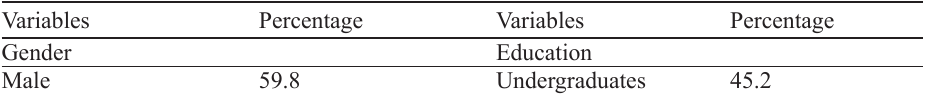
Table 2. Demographic information (n =